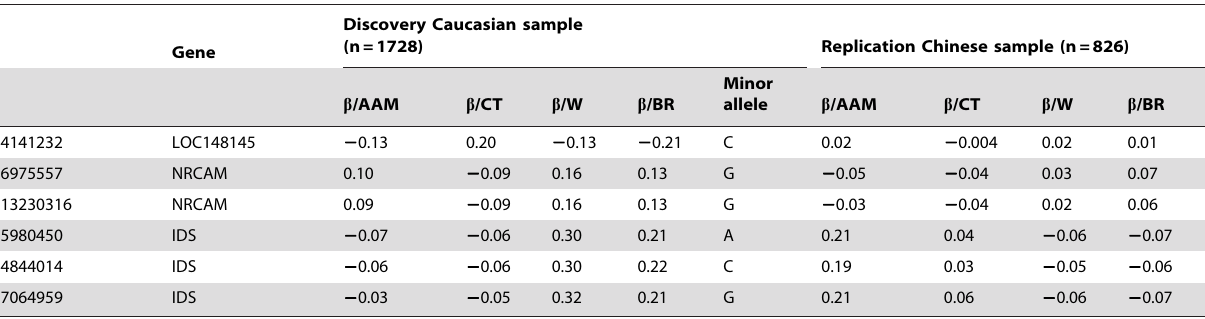
Table 6. The effect direction of the SNPs in discovery and replication samples.